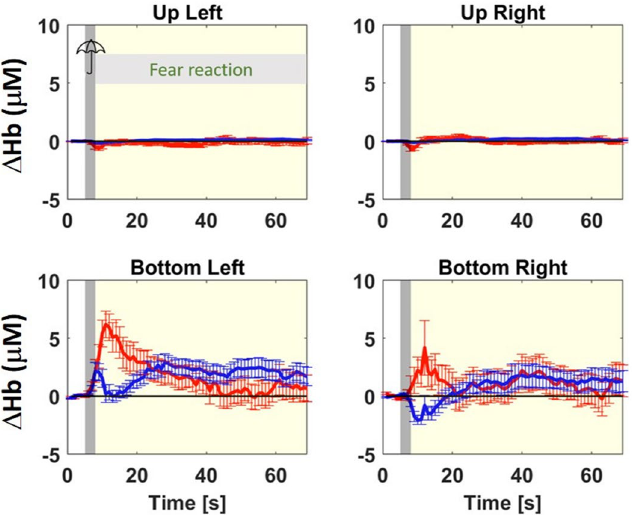
Figure 2. Group-average of [ΔO 2 Hb] (red lines) and [ΔHHb] (blue lines) , in μM, and their standard deviation during the startling test for extra-cerebral (up) tissue (top row) and cerebral (down) tissue (bottom row) and for the left (left column) and right (right column) hemisphere. In every subplot, the first 5 s is the baseline, followed by a 3 s startle stimulus (marked as gray area), and finally a 60 s fear reaction. The horizontal black line in every subplot indicates the zero